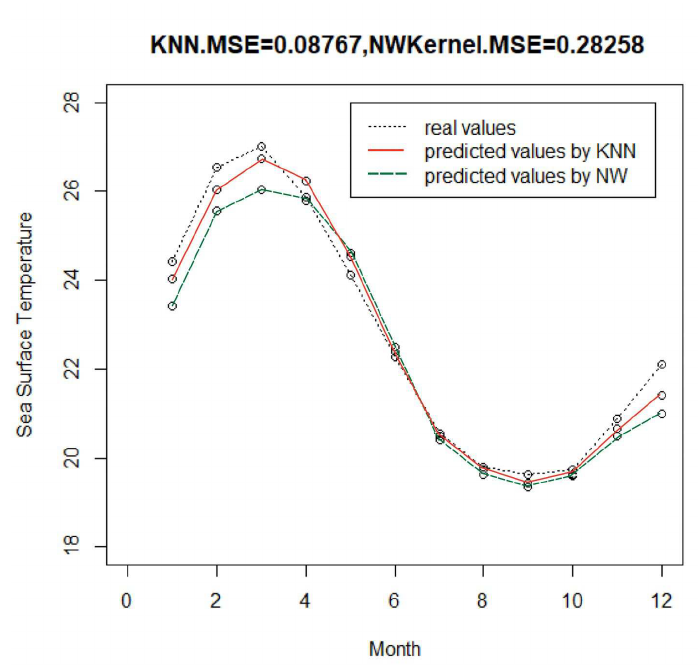
Figure 5. Forecast value of SST in 2020 by KNN method and NW